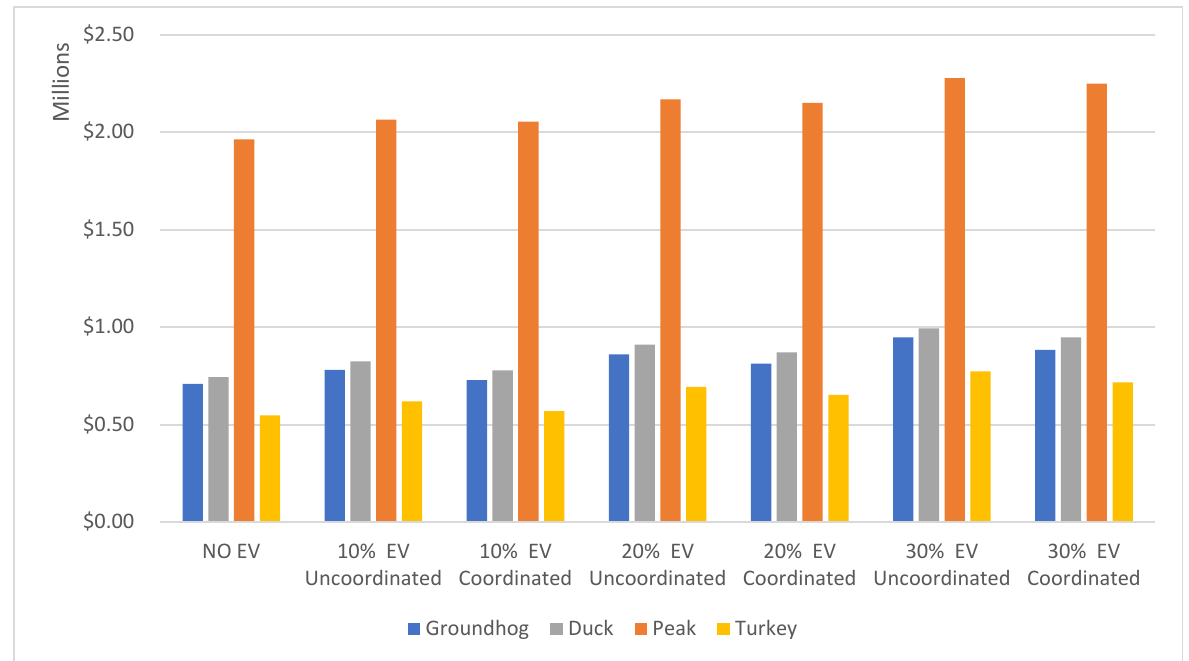
Figure 10. Average daily system operation cost for all the scenarios considered.